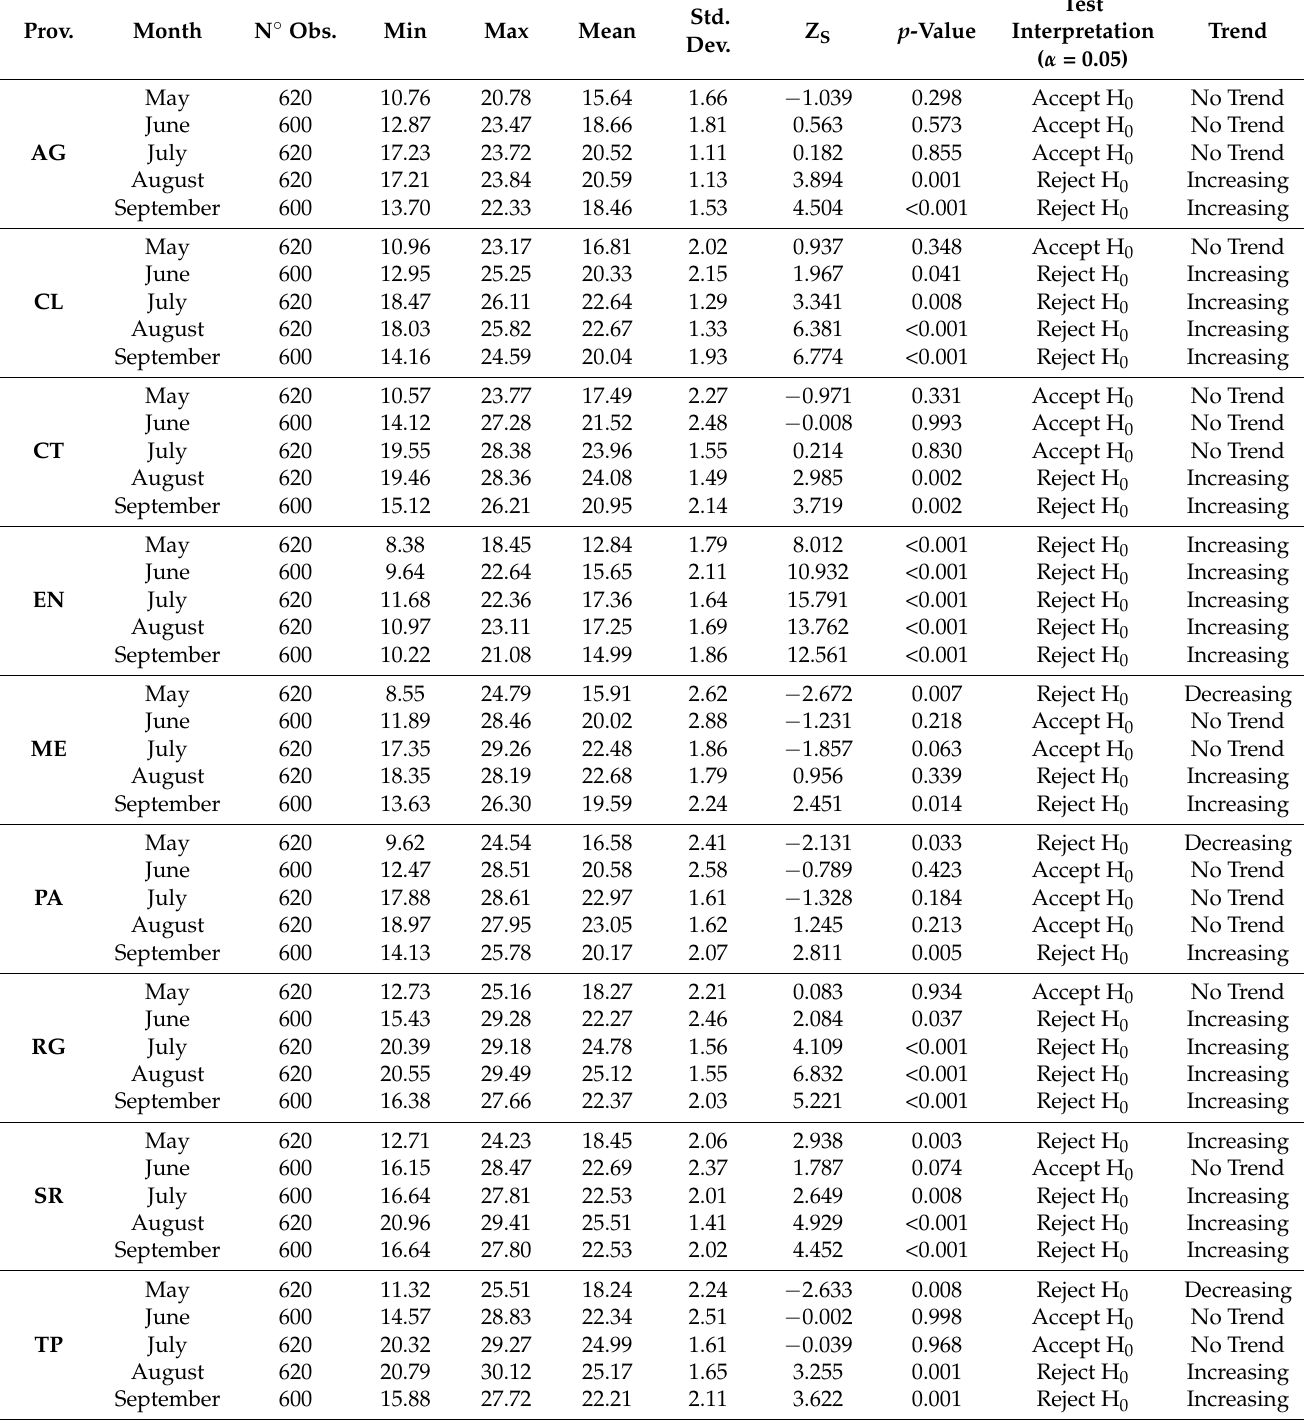
Table 2. Results of the Mann–Kendall test for TDI values in each province.